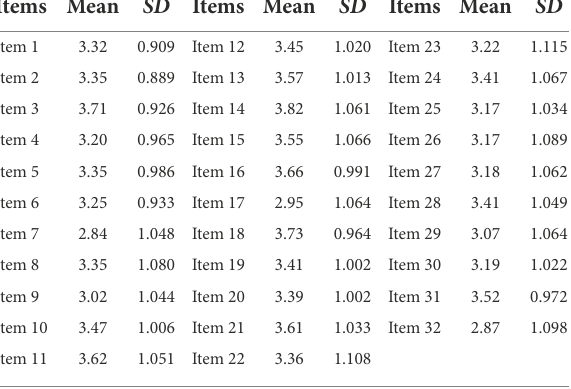
TABLE 1 Results of the discrete trend method analysis. Items Mean SD Items Mean SD Items Mean